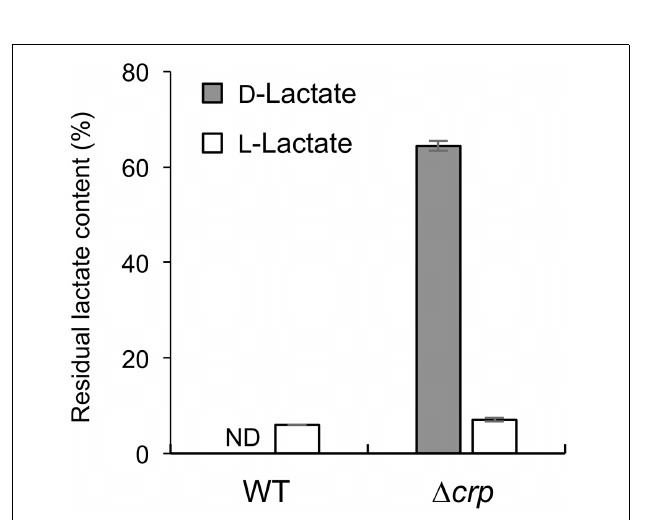
FIGURE 2 | Residual D - and L -lactate contents in WT and (cid:49) crp cultures. Error bars represent standard deviations calculated from at least triplicate independent experiments. ND, not detected.